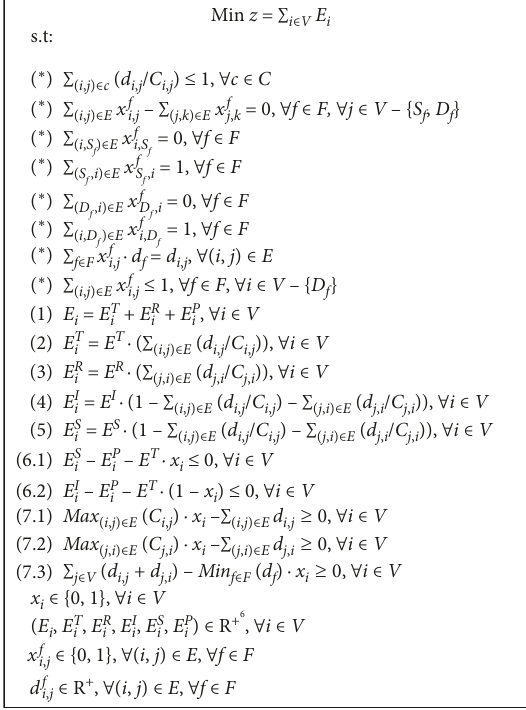
Figure 3: ILP formulation for minimal energy consumption